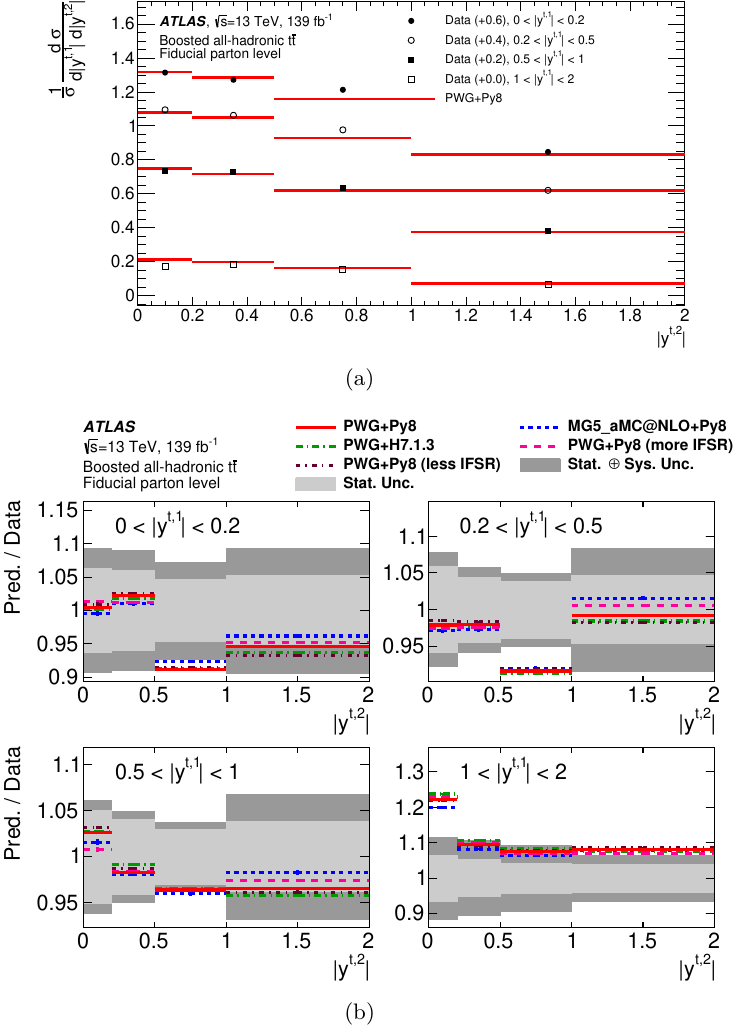
Figure 46 . (a) Normalized parton-level fiducial phase-space double-differential cross-sections as a function of the absolute value of the rapidity of the leading and the second-leading top-quark, compared with the Powheg+Pythia 8 calculation. Data points are placed at the centre of each bin and the Powheg+Pythia 8 calculation is indicated by solid lines. The measurement and the prediction are shifted by the factors shown in parentheses to aid visibility. (b) The ratios of various MC calculations to the normalized parton-level fiducial phase-space differential cross-sections. The dark and light grey bands indicate the total uncertainty and the statistical uncertainty, respectively, of the data in each